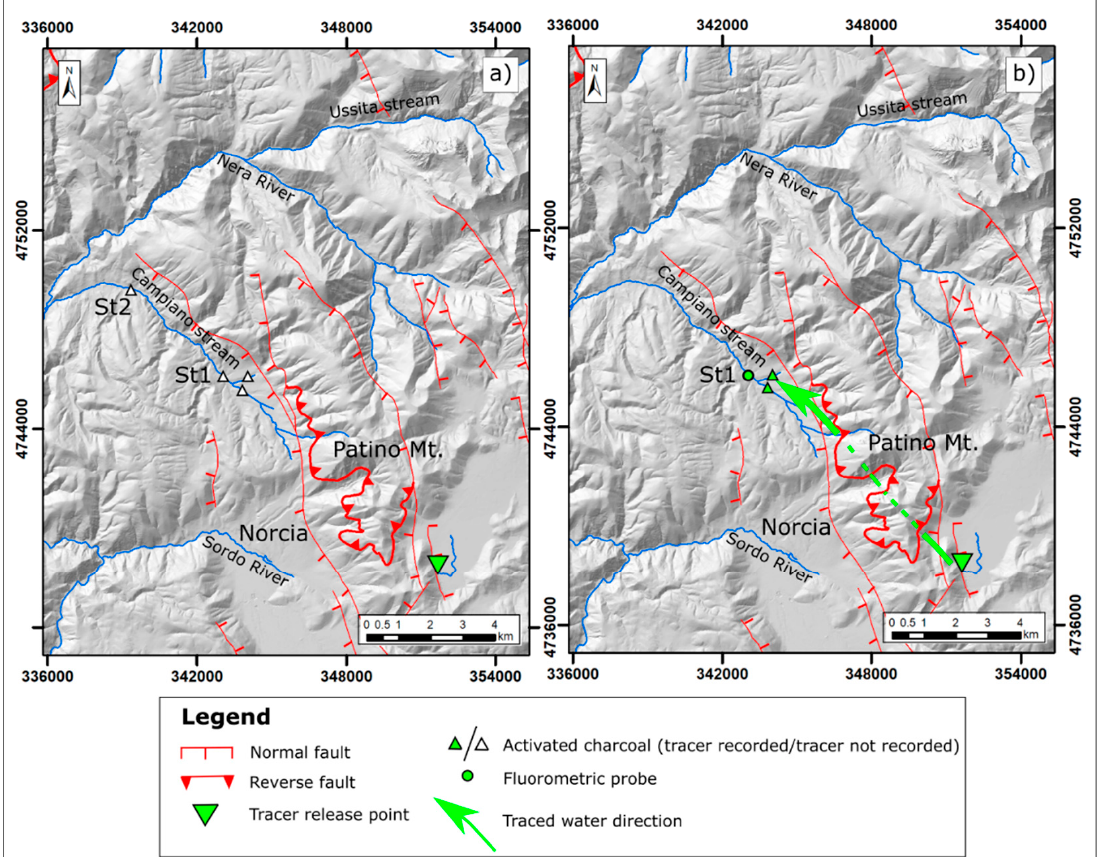
Figure 6. Main tracers’ direction from the release point (Mergàni sinking stream) to the analysed basin (Campiano catchment) location of the main tectonic lineaments. ( a ) Pre-seismic conditions; ( b ) post-seismic conditions.